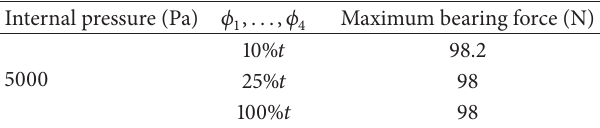
Table 2: Membrane properties.